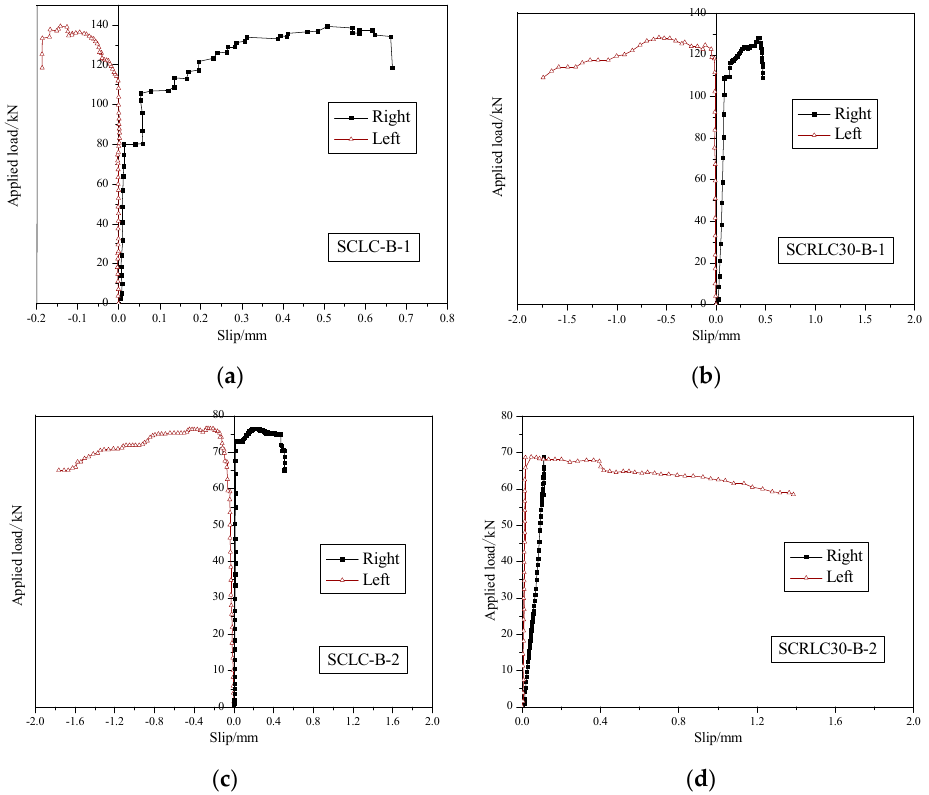
Figure 14. Load–slip behavior of different composites slabs. ( a ) SCLC-B-1, ( b ) SCRLC30-B-1, ( c ) SCLC-B-2, ( d ) SCRLC30-B-2.